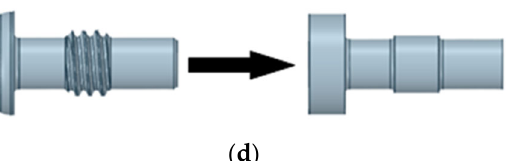
Figure 8. Modifications of CAD models for FEM analysis. ( a ) Medin load screw; ( b ) Tantum load screw; ( c , d ) Fixation screws.